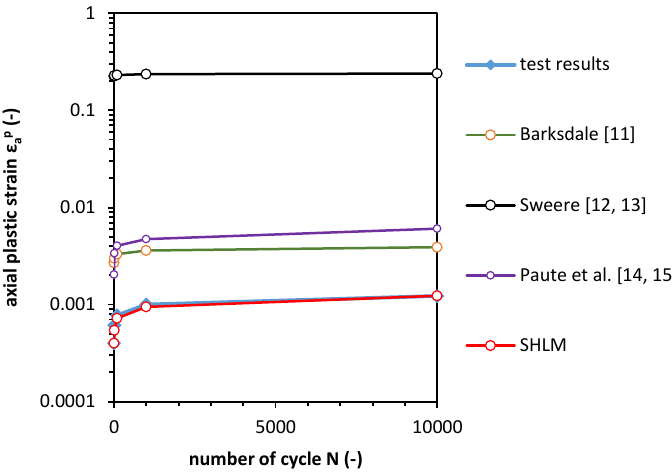
Figure 14. Comparison between the test results and the plastic strain models for sample 1.1.